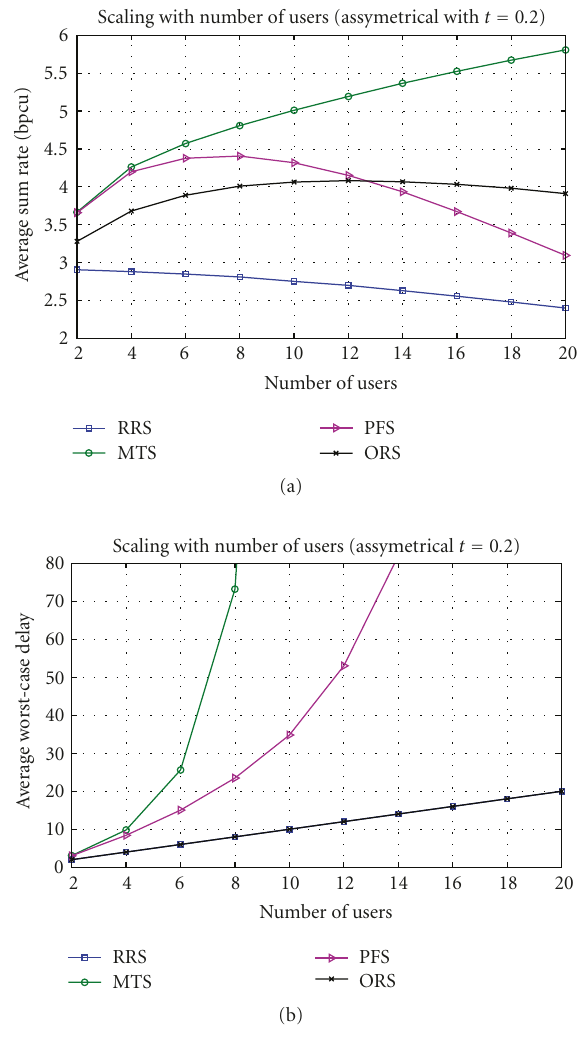
Figure 3: Average sum rate and worst-case delay versus number of users for asymmetrically distributed users.